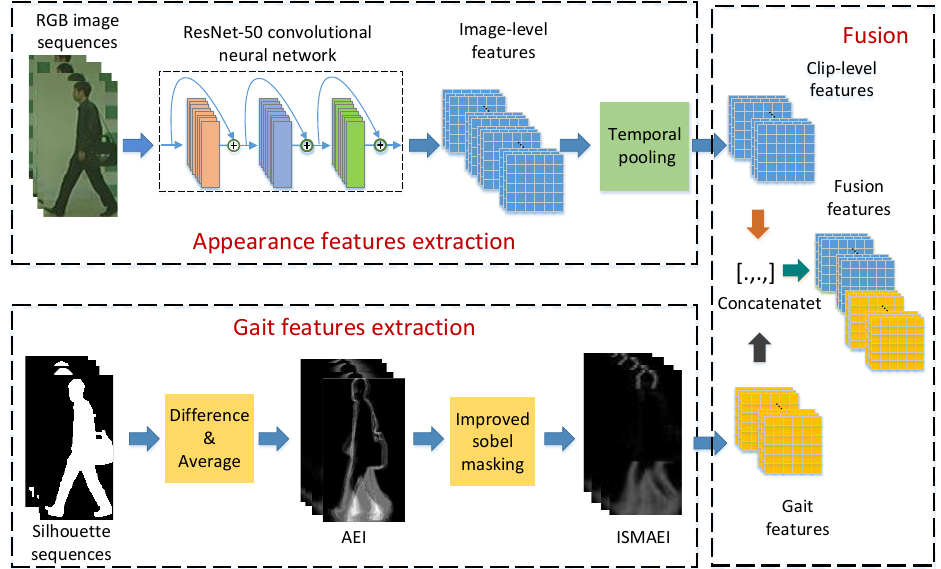
Figure 2. The framework of the proposed method includes three parts: appearance feature branch, gait feature branch, and feature fusion. AEI denotes active energy image, and ISMAEI represents Improved-Sobel-Masking active energy